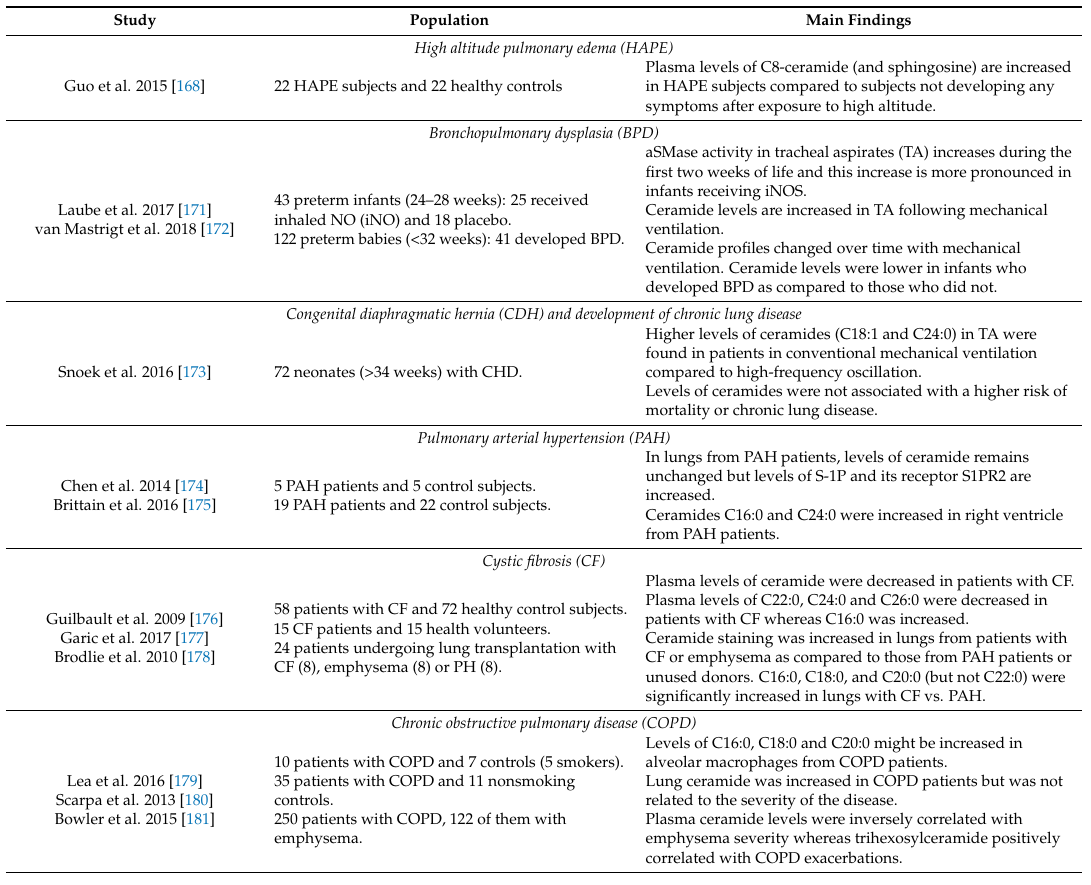
Table 4. Ceramide and lung